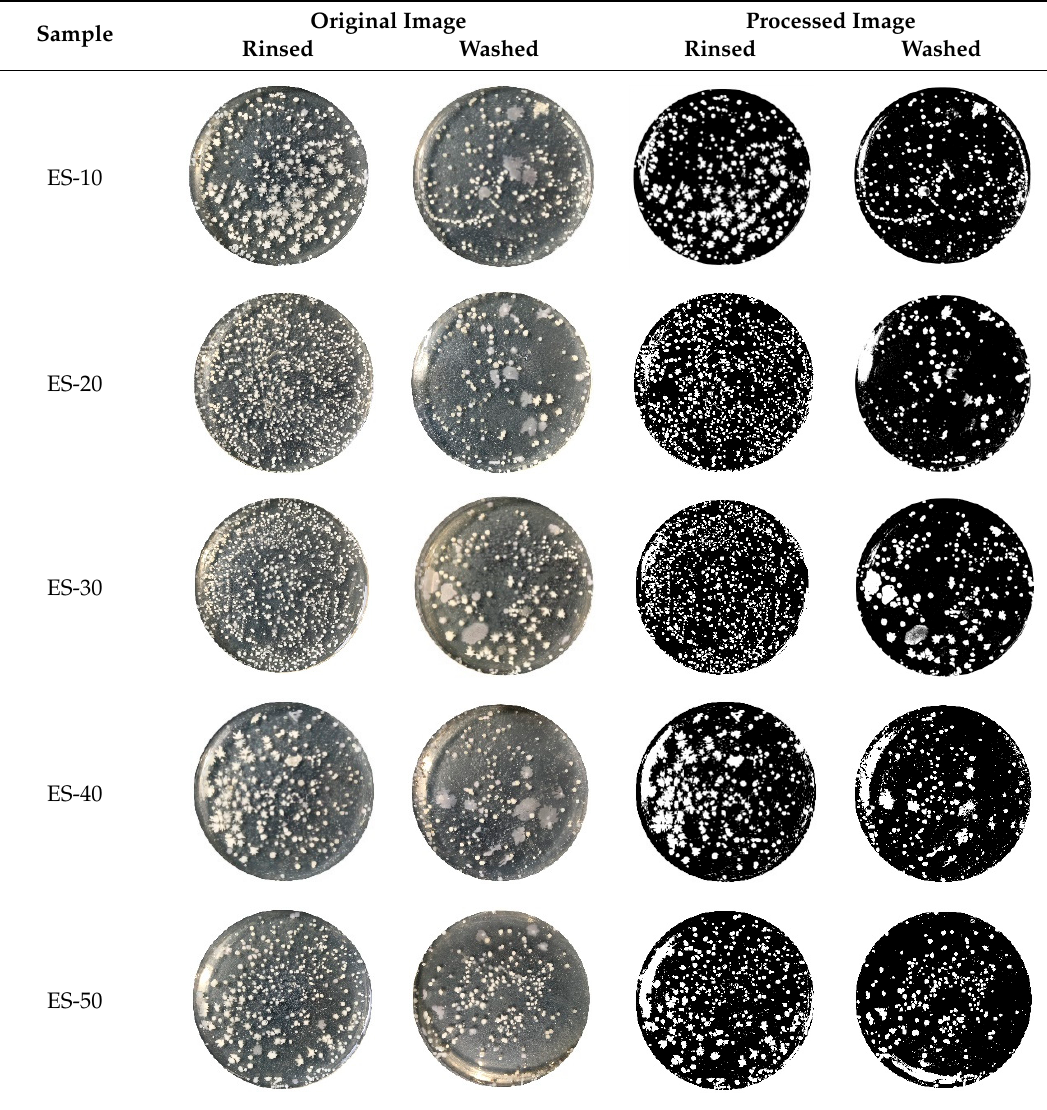
Table 5. Original and processed images of marine bacterial colonies.